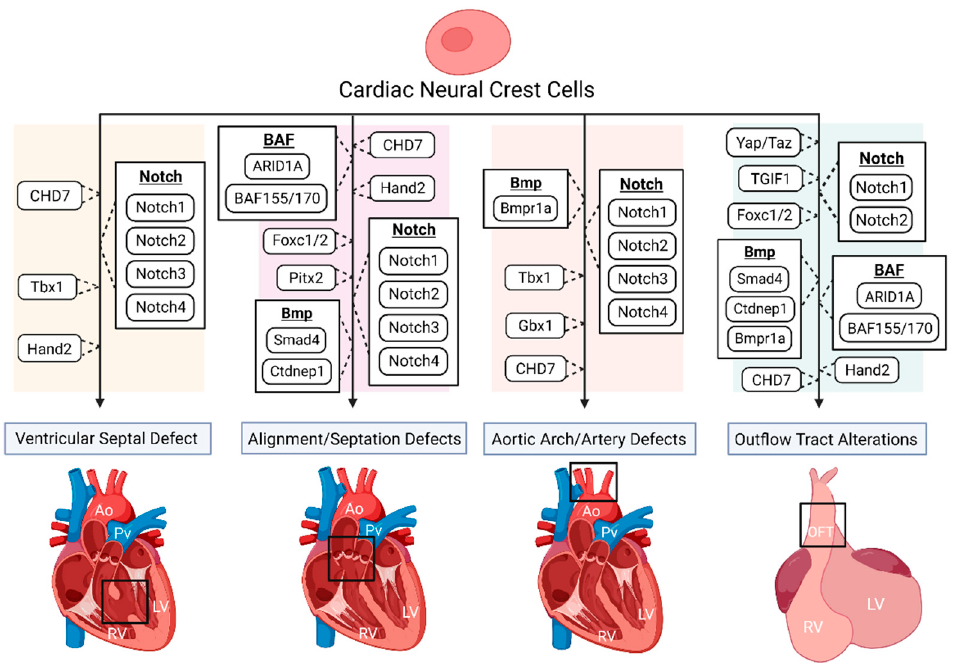
Figure 1. The disruption of various genes and signaling pathways, indicated to be important for proper cardiac neural crest (NC) contribution, results in numerous congenital heart defect (CHD) phenotypes. Such phenotypes include ventric- ular septal defect (VSD), various vascular defects including misalignment of the aorta and pulmonary trunks and aortic artery abnormalities, and outflow tract (OFT) alterations, such as OFT constriction and improper septation. Loss of Tbx1 in mice has been shown to alter the environment of migrating neural crest cells (NCCs), producing great vessel abnormal- ities and aortic arch interruption, while also presenting with VSD in patients. CHD7 mutations within NCCs can produce septum defects such as VSD, and vascular alterations such as double outlet right ventricle (DORV) and interrupted aortic arch, , , along with inhibiting NC contributions to the OFT. In NCCs, disrupted Notch2 results in a narrowed OFT and OFT arteries, while mutations of all Notch-target genes ( Notch1, Notch2, Notch3, Notch4) have been shown to result in VSD, along with vascular abnormalities such as pulmonic stenosis and aortic arch patterning defects. The deletion of a known bone morphogenetic protein (Bmp) inhibitor, Ctdnep1 , produced premature and asymmetric OFT septation, pulmonary closure, premature NCC compaction, and embryonic death, while the loss of the Bmp receptor Bmpr1a , resulted in short- ened OFTs leading to persistent truncus arteriosus (PTA), along with occasional aortic arch abnormalities. It was also found that the deletion of Smad4 , located downstream of the Bmp network, also resulted in shortened OFTs, along with some hearts presenting with no OFT septation, resulting in PTA. The ablation of Yap and Taz , key components of the Hippo signaling pathway, in NCCs have been shown to disrupt smooth muscle expression and differentiation of the OFT. Deletions of BAF155 and BAF170 in NCCs have resulted in impaired NCC contribution for OFT development, while a loss of ARID1A , a BAF (Brg1/Brm-associated factors) subunit, has shown improper NC contribution for OFT development with producing conotruncal septation defects. The disruption of Pitx2 and Pitx2 upstream regulators suggests a negative impact on cardiac NC abilities for proper vasculature development. Hand2 deletions in NCCs present with a large variety of altered cardiac morphology, such as impaired OFT development, DORV, and VSD. Lack of OFT septation is also seen with the deletion of TGIF1 in NCCs. Deletion of Foxc1/2 in mice presents with lacking or shortened OFTs, along with improper OFT septation and PTA. Ao, aorta; Pv, pulmonary vessel; LV, left ventricle; RV, right ventricle; OFT, outflow tract. Created with Biorender.com (accessed on 28 July